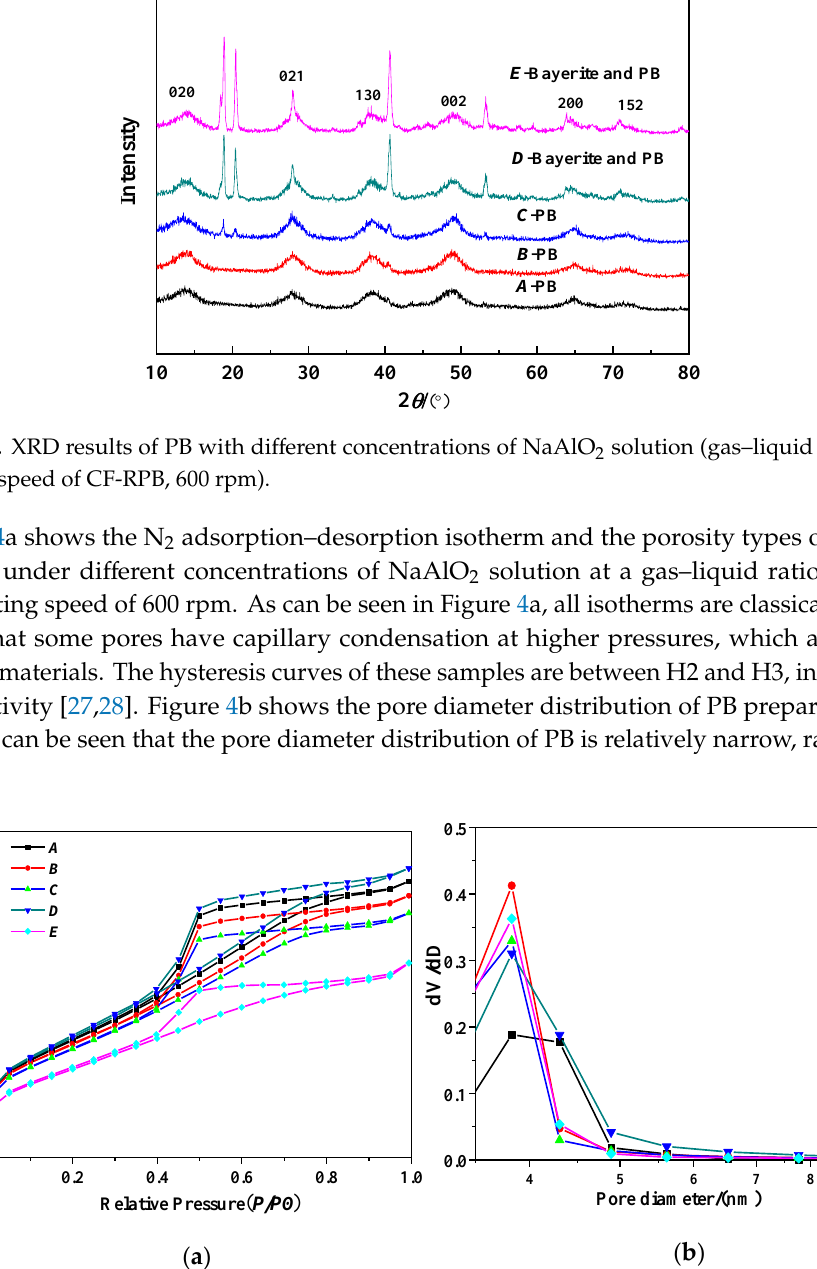
Figure 4. ( a ) N 2 adsorption–desorption isotherm results of PB with di ff erent concentrations of NaAlO 2 solution, ( b ) pore size distribution of PB with di ff erent concentrations of NaAlO 2 solution (gas–liquid ratio, 1:1; rotating speed of CF-RPB, 600 rpm).